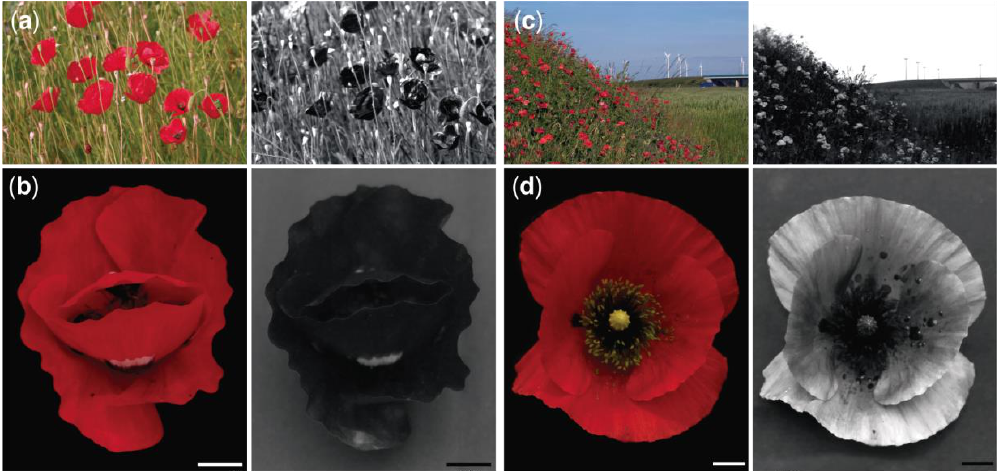
Figure 1. RGB and UV images of flowers of P. rhoeas . ( a ) A field containing flowers of P. rhoeas in the East Mediterranean. ( b ) A P. rhoeas flower collected in the East Mediterranean. ( c ) A field with P. rhoeas flowers in Central Europe. ( d ) A P. rhoeas flower collected in Central Europe. Scale bars: (b,d) 1 cm.